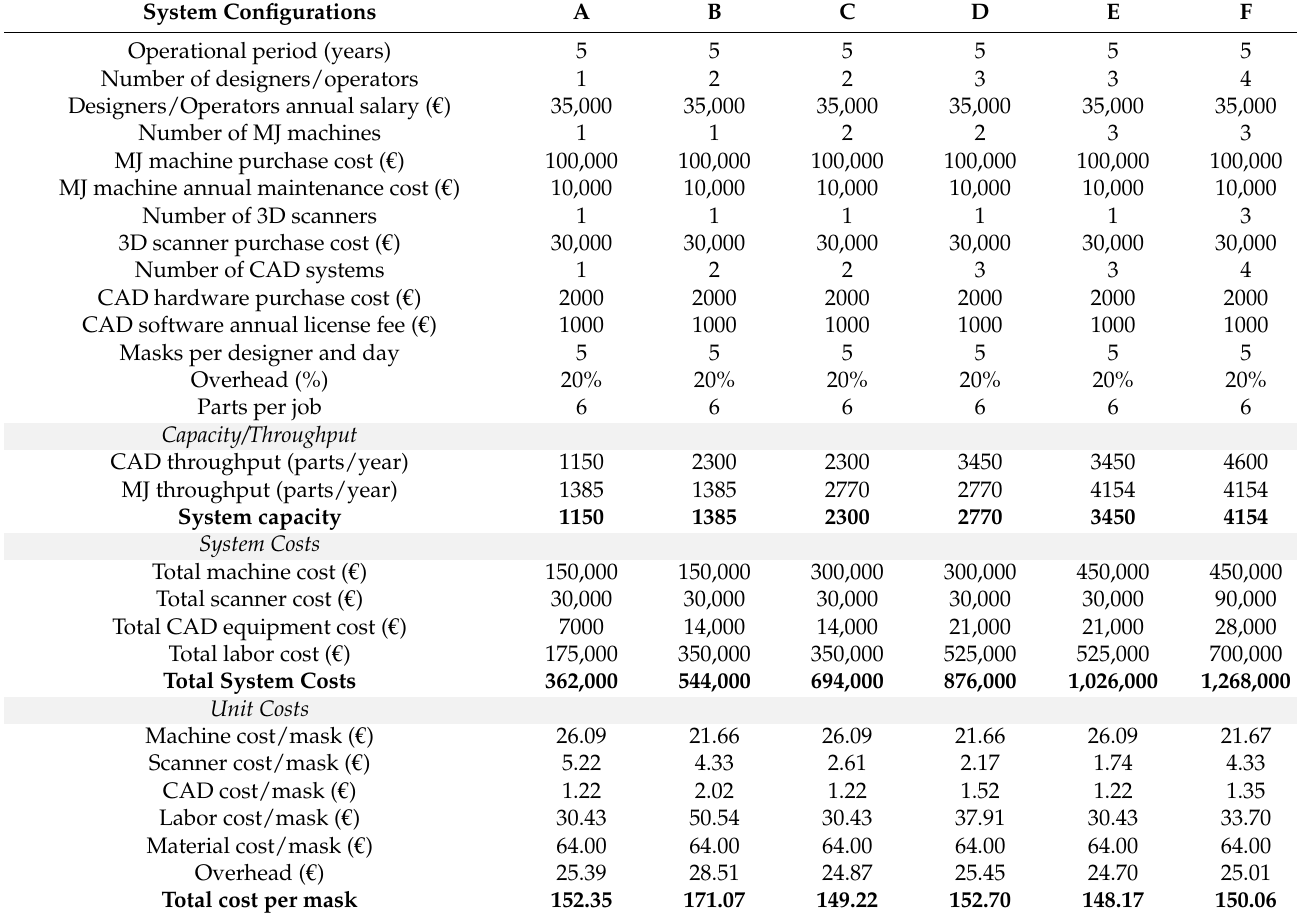
Table 3. Cost analysis for different system